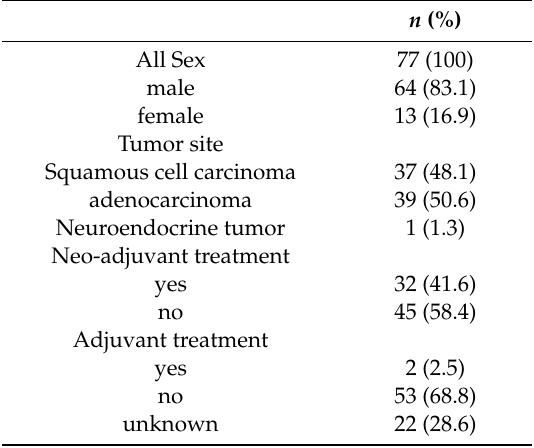
Table 2. Characteristics of the analyzed cohort of patients with esophageal carcinoma.